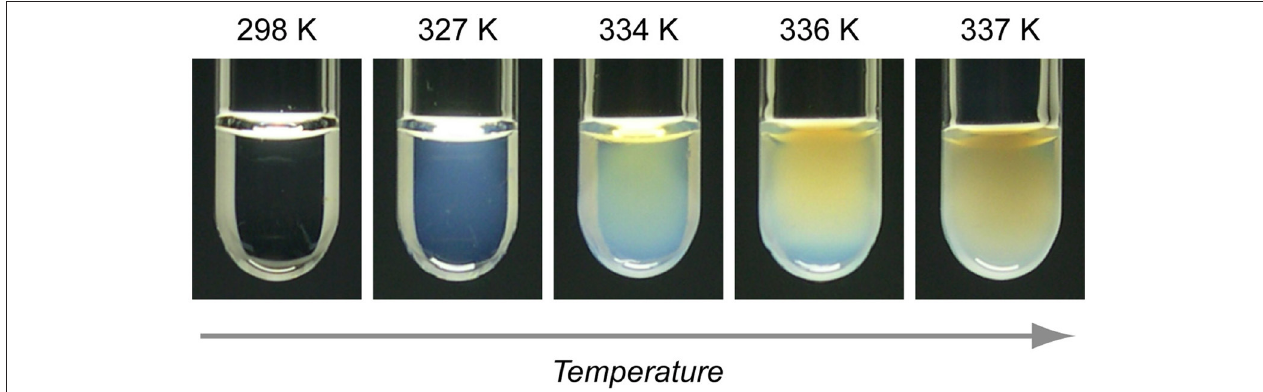
FIGURE 8 | Result of visual inspection of D 2 O/3MP/NaBPh 4 mixture ( φ 3MP = 0.35 and C salt = 13 mmol/L). The mixture is blue at T = 327K, green at 334 K, and orange at 337 K. The figure is reproduced from Sadakane et al. [16] (Copyright 2007 by The Physical Society of Japan). As per the copyright holder’s policies, no permission is required for the use of figures by the authors of the original article.